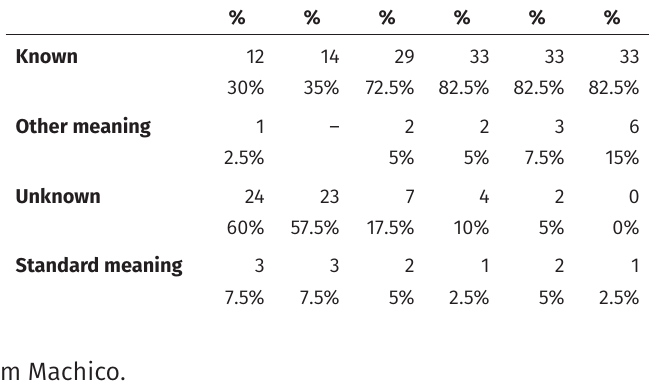
Table 2: Results from Funchal.